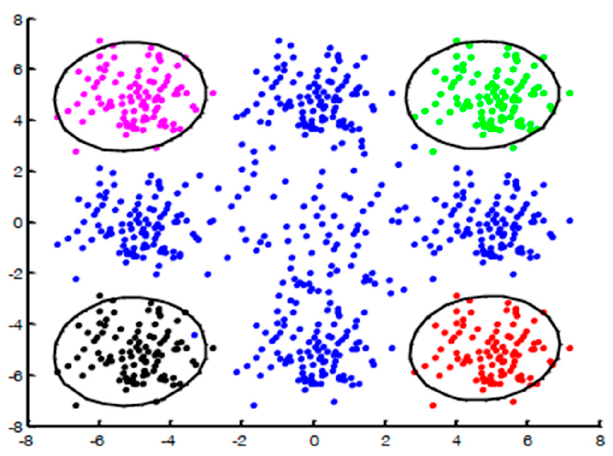
Figure 2. The MultiKOC trained over the positive examples. As can be seen, the positive examples are classified into four different clusters.